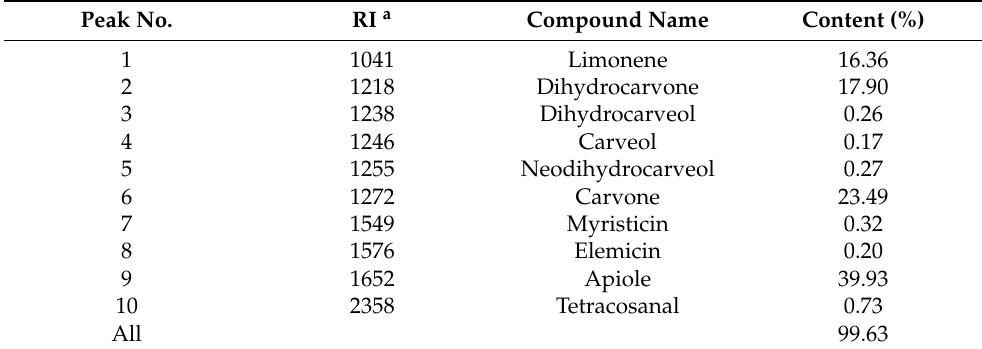
Table 1. Chemical composition and content of